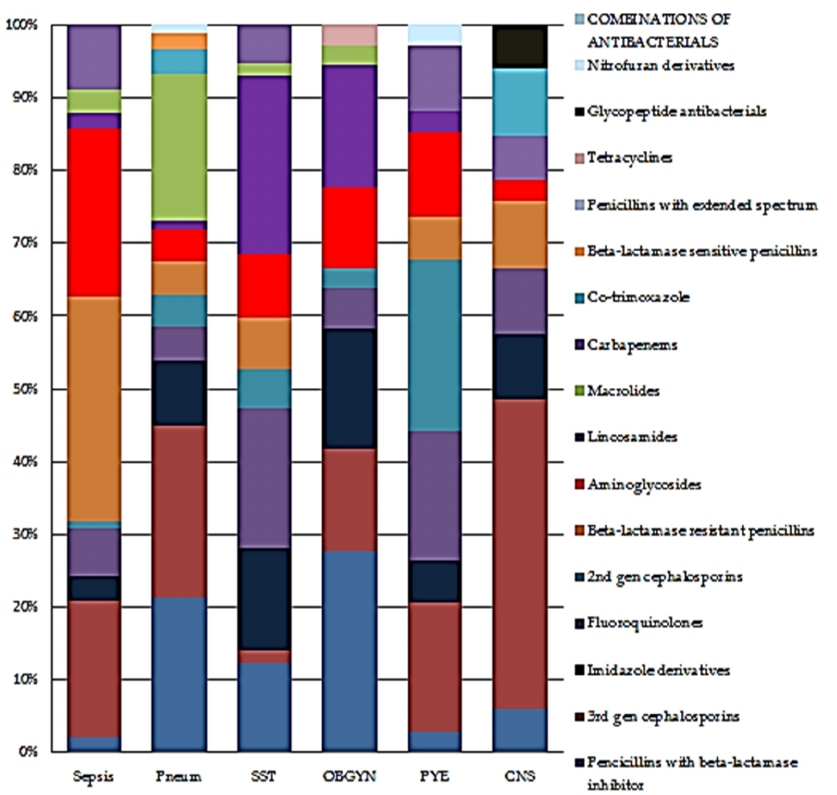
Figure 2. Top 6 indications disaggregated by antibiotic class. Abbreviations: Pneu: pneumonia or lower respiratory tract infection, SST: skin and soft tissue, OBGY: obstetric/gynaecological infections, Pye: upper urinary tract infection, CNS: infection of central nervous system.